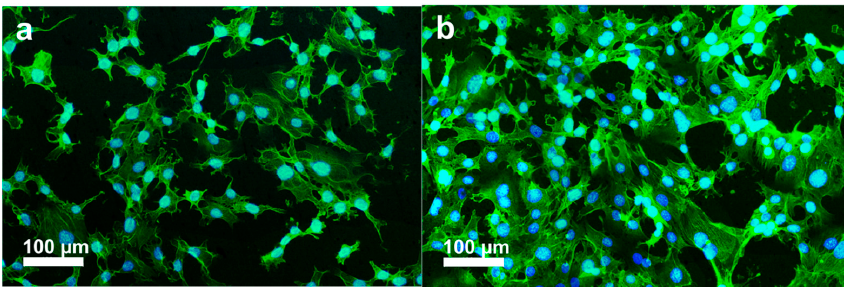
Figure 8. Fluorescence micrographs of osteoblasts cultured on PEEK/(15% nHA)-(1.88% MWNT) hybrid and stained for F-actin cytoskeleton (green) and nucleus (blue) at ( a ) day 1 and ( b ) day 3.